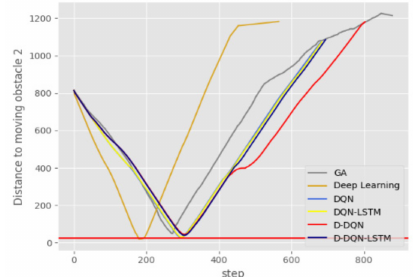
Figure 19. Change in the distance between AUV and moving obstacle 2 in a complicated